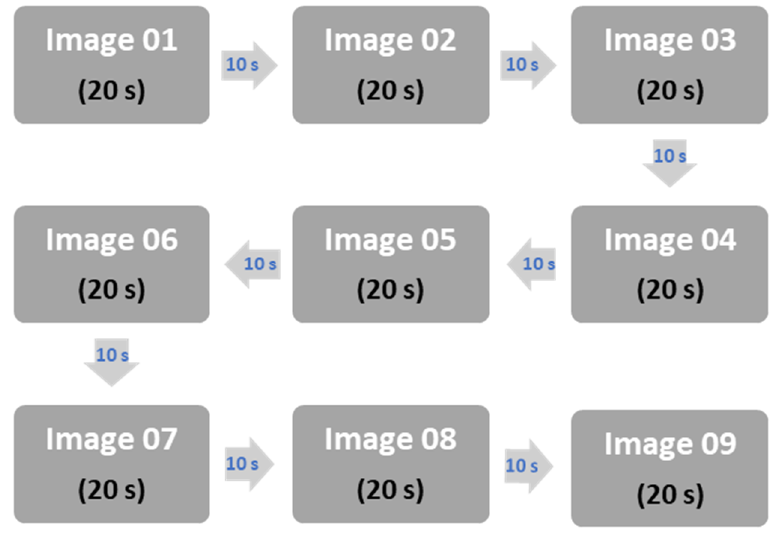
Figure 4. The EEG measurement procedure sequence shows the experimental duration.